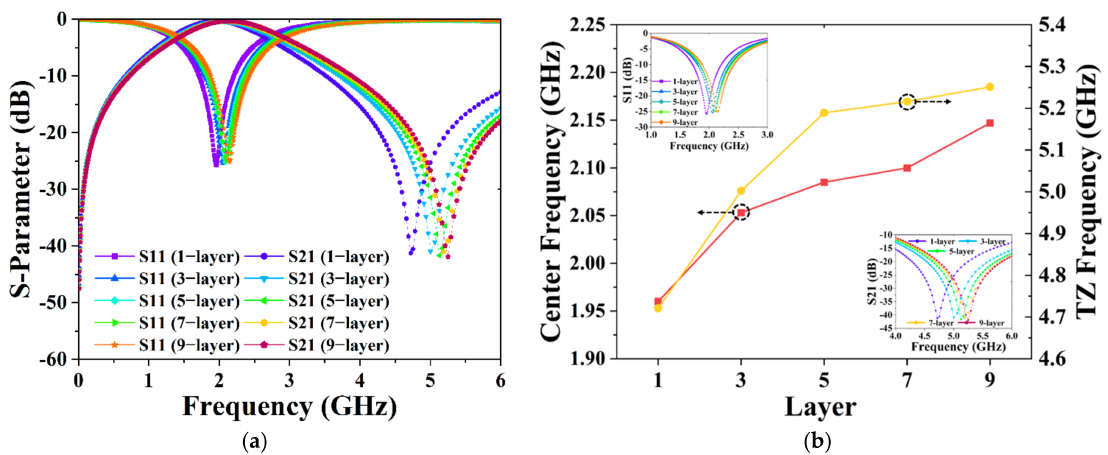
Figure 9. ( a ) BPF performance based on coarse-tuning. ( b ) Results of center frequency and transmis- sion zero frequency based on coarse-tuning, as well as a partial enlarged view of the S-parameter.